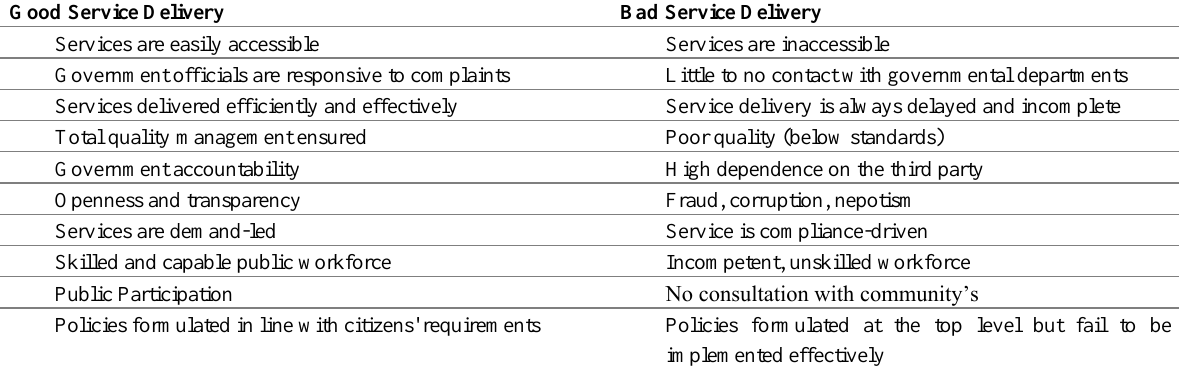
Table 1: Good vs Bad Service